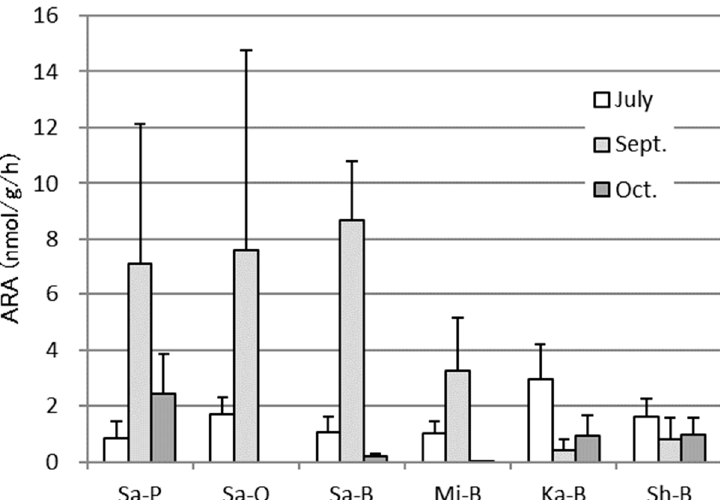
Figure 6. Acetylene reduction activities (ARA) in tubers from sweet potato cultivars of different origins at three measurement time points, July, September, and October, during the course of cultivation in an experimental field. The same footnote as Figure 1. The error bars indicate standard errors ( n = 5), and no significant difference was detected at P < 0.05 by Tukey’s test.